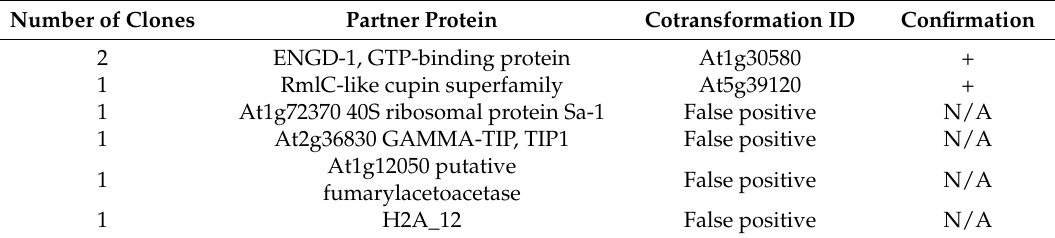
Table 2. ROC3M interaction partners.